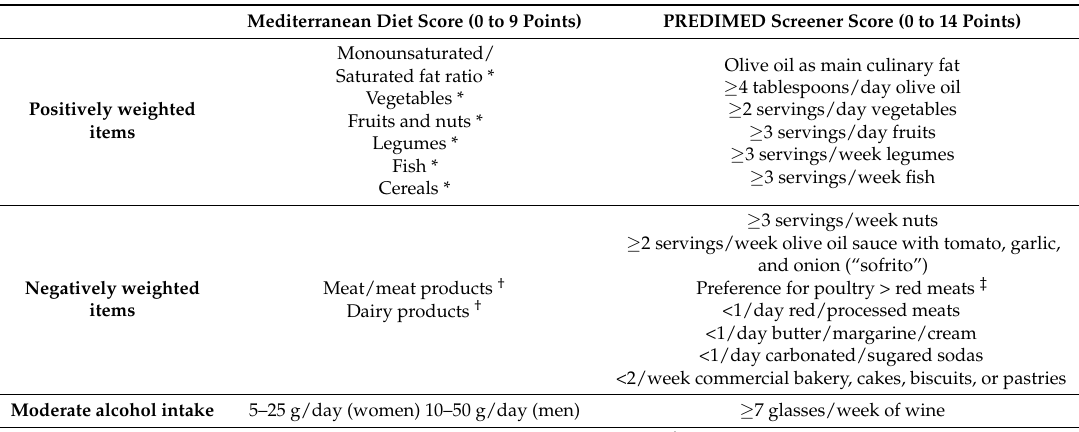
Table 1. Two frequently used operational definitions of the Mediterranean